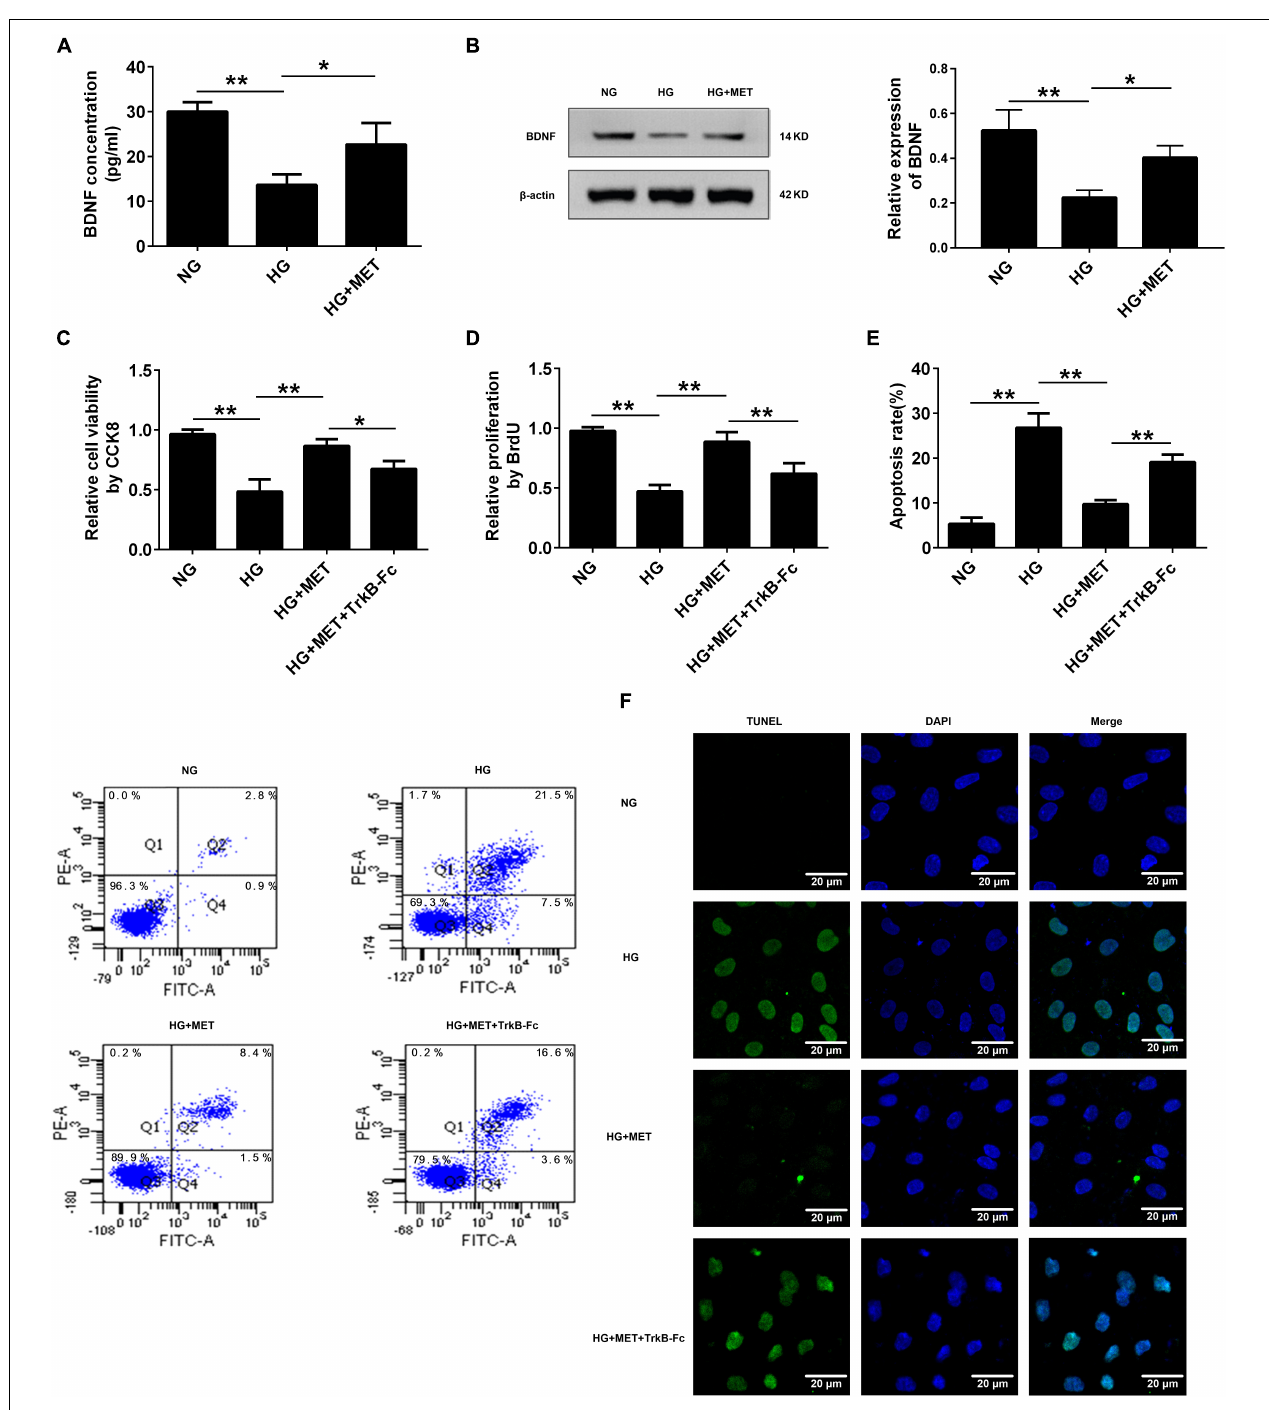
FIGURE 4 | Metformin improved cell proliferation and ameliorated cell apoptosis by modulating BDNF expression. (A) ELISA analysis of BDNF expression in HUVECs treated with NG, HG (33.3 mmol/l) and HG + MET (0.01 mmol/l) conditions. (B) Western blot analysis of BDNF expression in HUVECs treated with NG, HG, and HG + MET. The histograms represent the relative BDNF intensity. (C) CCK8 assay in HUVECs treated with the NG, HG, HG + MET, and HG + MET plus 1 µ g/ml TrkB-Fc (HG + MET + TrkB-Fc) for 24 h. (D) BrdU incorporation assay in HUVECs treated with NG, HG, HG + MET, and HG + MET + TrkB-Fc. (E) Annexin V/PI assay of cell apoptosis in HUVECs treated with the NG, HG, HG + MET, and HG + MET + TrkB-Fc conditions. The histograms represent the apoptosis rates in the four groups. (F) Representative photographs of TUNEL staining in the different groups. The results are expressed as the means ± SD. ∗ p < 0.05, ∗∗ p < 0.01; one-way